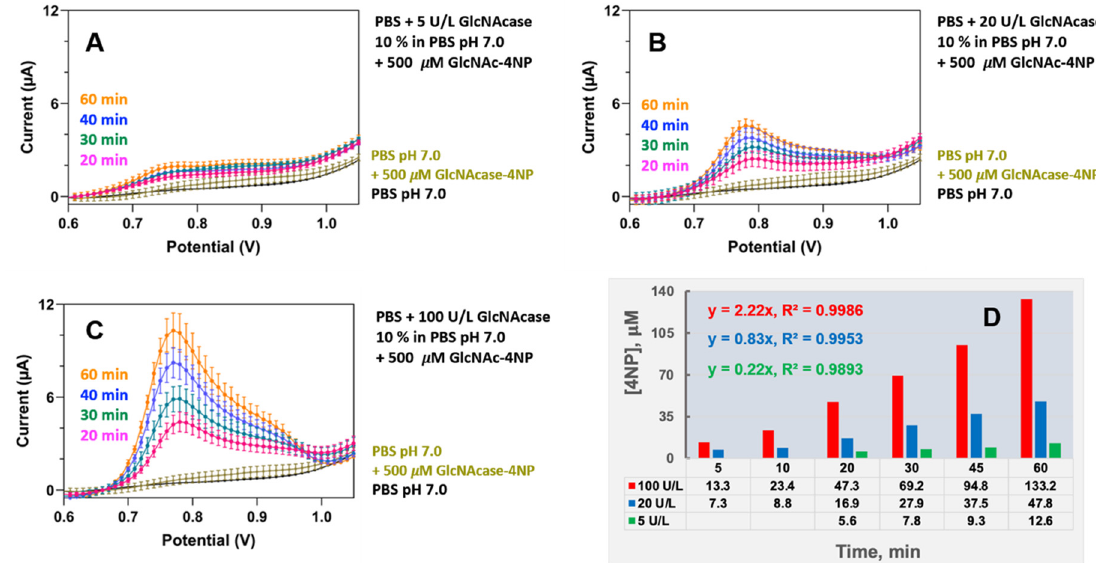
Figure 4. Assessment of low (5 U/L, ( A )), medium (20 U/L, ( B )) and high (100 U/L, ( C )) levels of the kidney status biomarker N-acetylglucosaminidase (GlcNAcase) in 0.1 M PBS, pH 7.0 model samples. A total of 300 µ L of the simulated urine samples was added to 2700 µ L of 0.1 M PBS, pH 7.0 containing 0.5 mM GlcNAc-4NP. 4NP differential pulse voltammograms (DPVs), recorded 20, 30, 45 and 60 min after initiation of the trial, visualized 4NP release through the concentration-dependent action of GlcNAcase on the labelled substrate with progressively increasing anodic peak currents. ( D ) Bar chart plot of anodic 4NP peak current magnitudes, i p , as functions of catalytic time. Insets in ( D ) are the slopes of regression lines through plots of the i p values as listed below the x-axes vs. corresponding reaction time. The average percentage standard deviation for the y-axes data point values of the triplicate trial, not specifically visualized here as error bars, was (11 ± 5)%. Parameters for DPV acquisition were as listed in Figure 2.